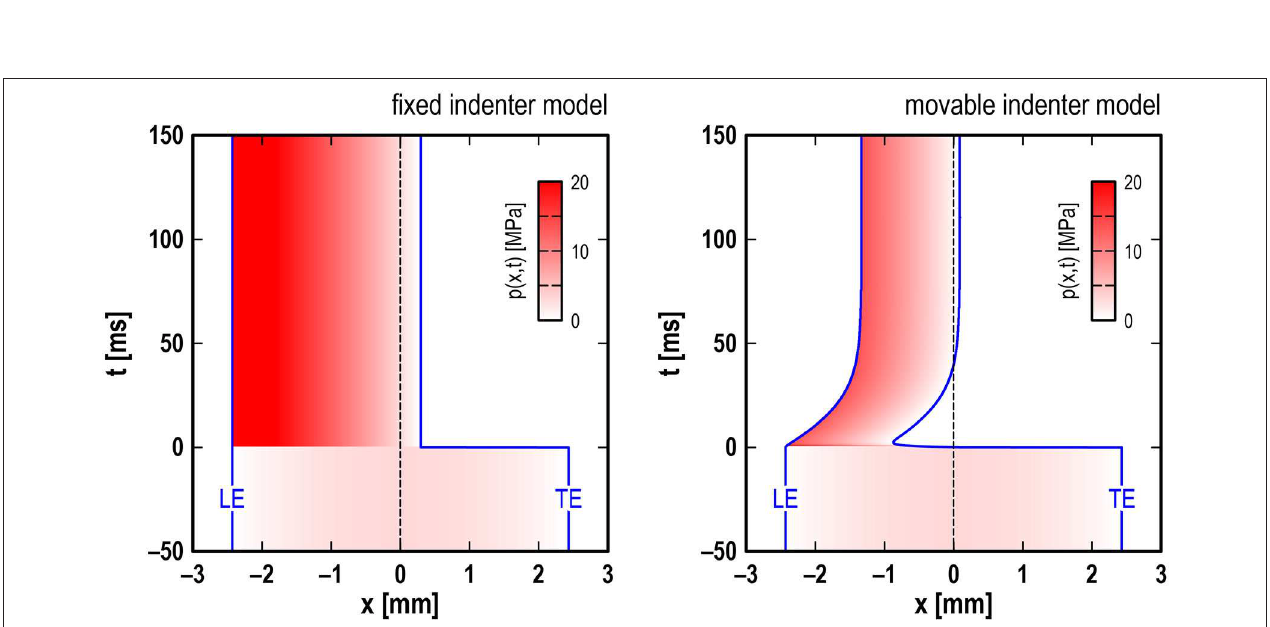
FIGURE 4 | Numerical results for fixed indenter model (Left) and movable indenter model (Right) : spatiotemporal changes in contact pressure p ( x,t ) under standard conditions (see Table 1 for parameter values). LE, leading edge of contact; TE, trailing edge of contact.